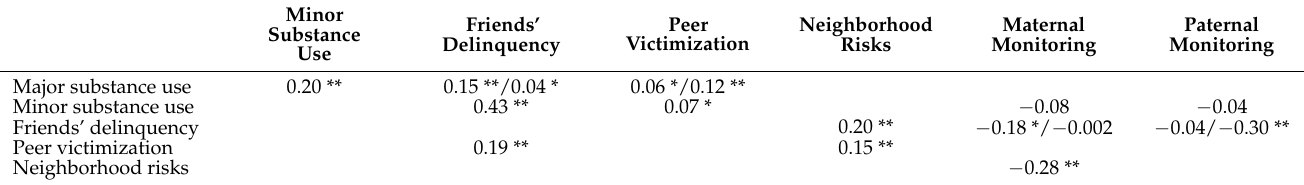
Table 5. Significant path coefficients (unstandardized) for